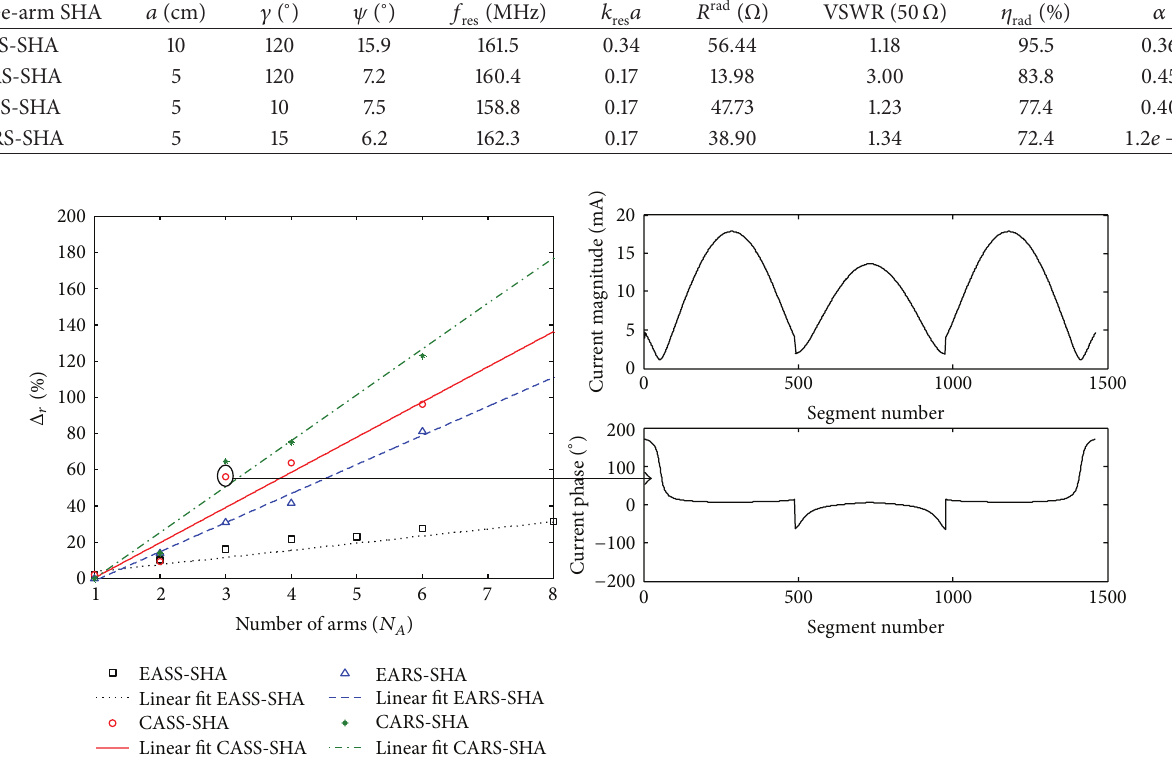
Figure 6: The relative deviation Δ 𝑟 and current distribution for three-arm